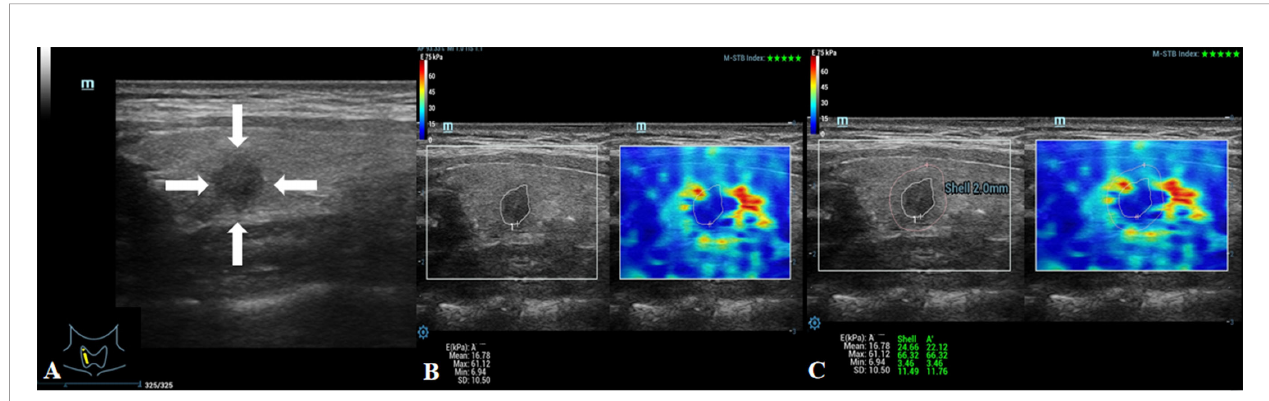
FIGURE 3 | Images showing an ACR-TIRADS 4 TN in a 48-year-old female patient. The pathological diagnosis after surgery was papillary thyroid carcinoma. (A) Conventional ultrasound image of the TN; the arrows point to the TN. (B) E value of the TN was 61.12 kPa. (C) E shell value of the TN was 66.32 kPa.